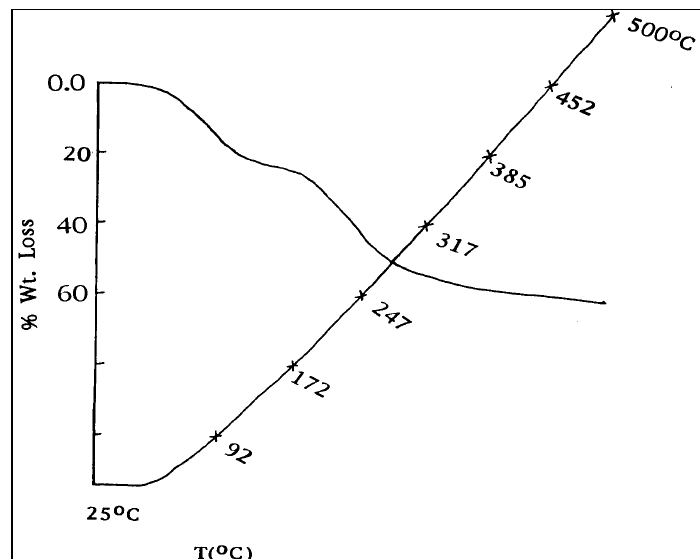
SO4. The TGA experimental conditions were the same 2